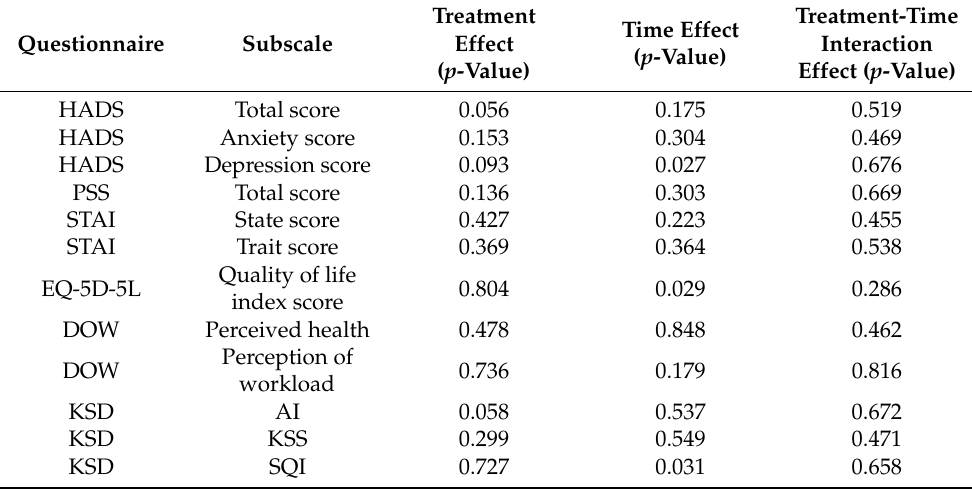
Table 2. Effect of treatment and time on psychological symptoms, general health and sleep quality. Results from the repeated measures ANOVA of the Hospital Anxiety and Depression Scale (HADS); the Perceived Stress Scale (PSS); the State and Trait Anxiety Inventory for adults (STAI); the Euro Quality of Life 5D-5L Index variable (EQ-5D-5L); perceived health (DOW) and perception of daily workload (DOW); Karolinska Sleep Diary’s (KSD’s) Awakening Index (AI), Karolinska Sleepiness Scale (KSS) and Sleep Quality Index